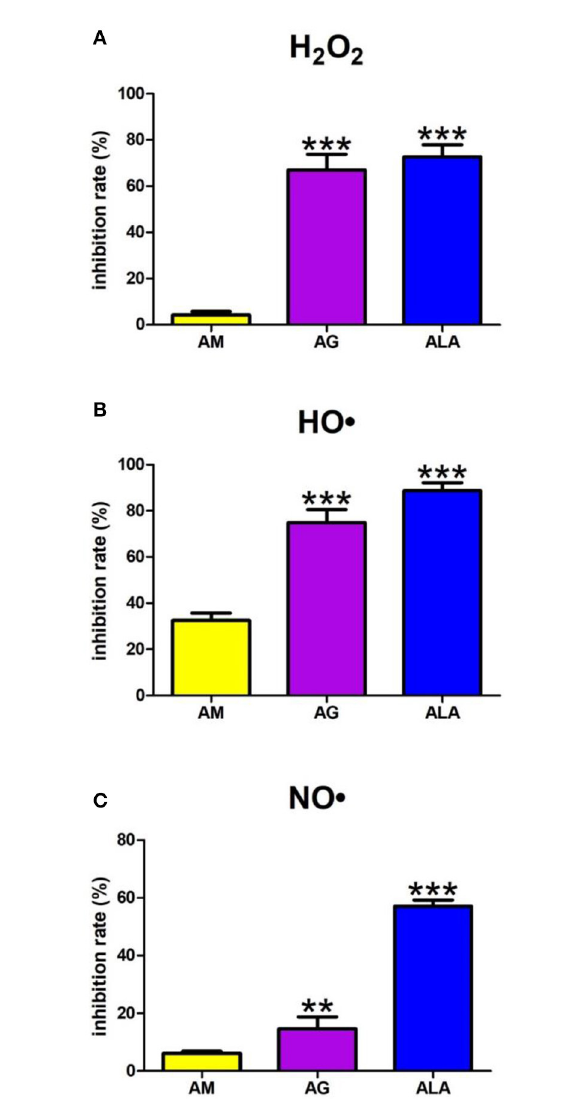
FIGURE3 Scavenging of reactive oxygen species (ROS): hydrogen peroxide (H 2 O 2 ) (A) , hydroxyl radical (HO • ) (B) as well as nitric oxide (NO • ) (C) by agomelatine and other additives. AG, aminoguanidine; ALA, α -lipoic acid; AM, agomelatine. ** p < 0.01 vs. control (agomelatine); *** p < 0.001 vs. control (agomelatine).